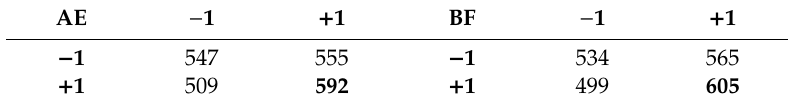
Table 6. Analysis of the e ff ects of interactions AF and BE on the hardness of the matrix constituent. AE